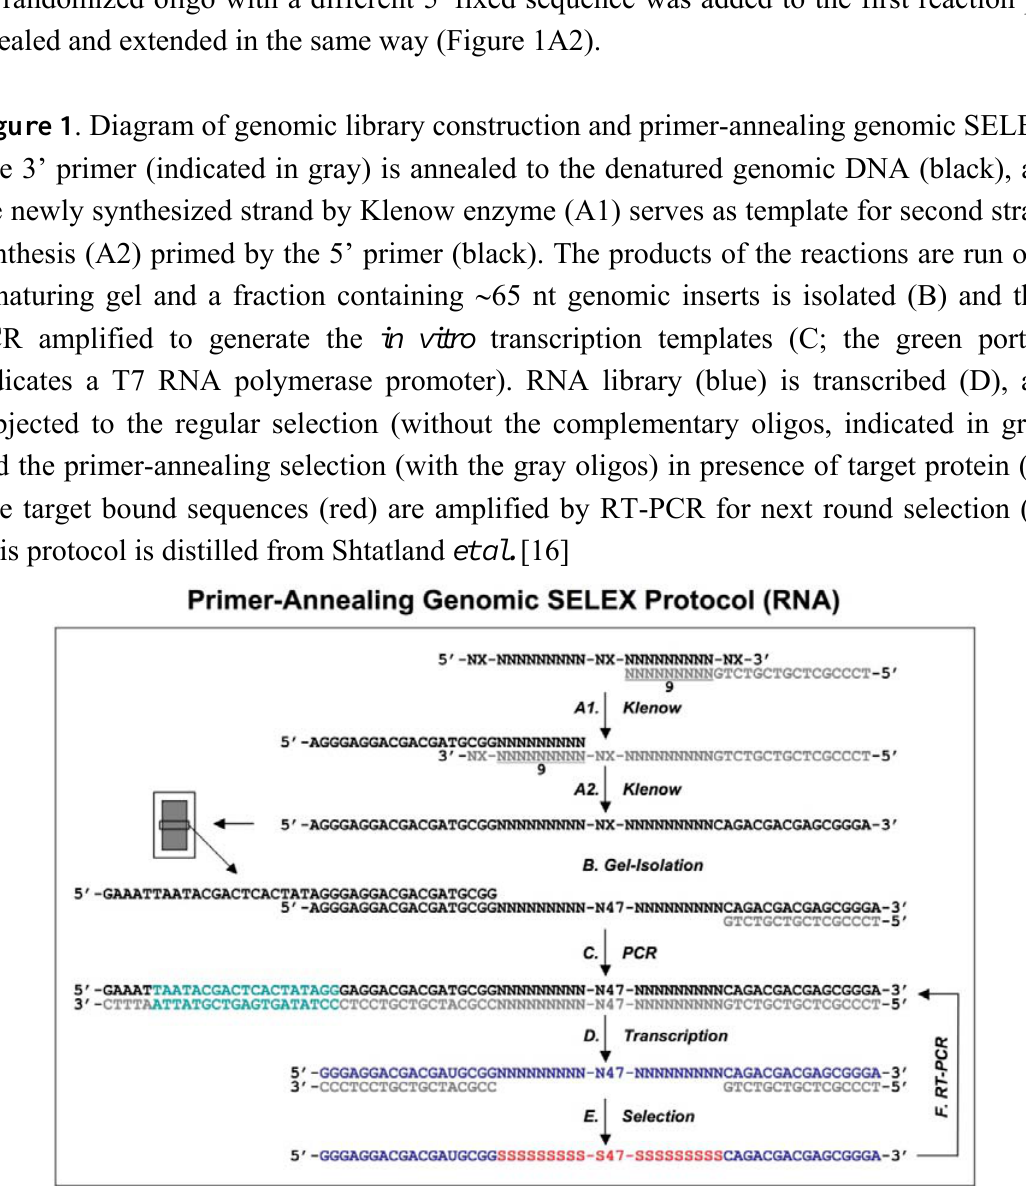
Figure 1 . Diagram of genomic library construction and primer-annealing genomic